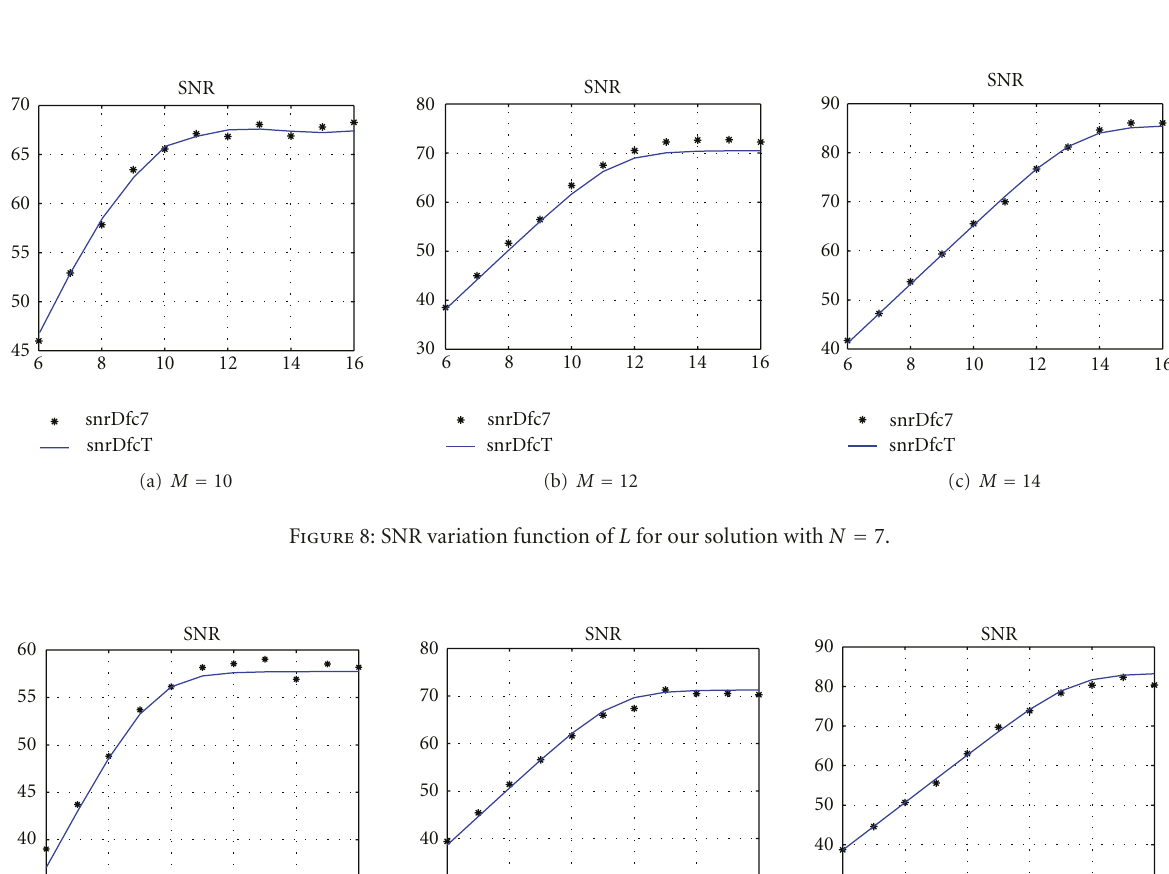
Figure 7: SNR variation function of M when M = L .